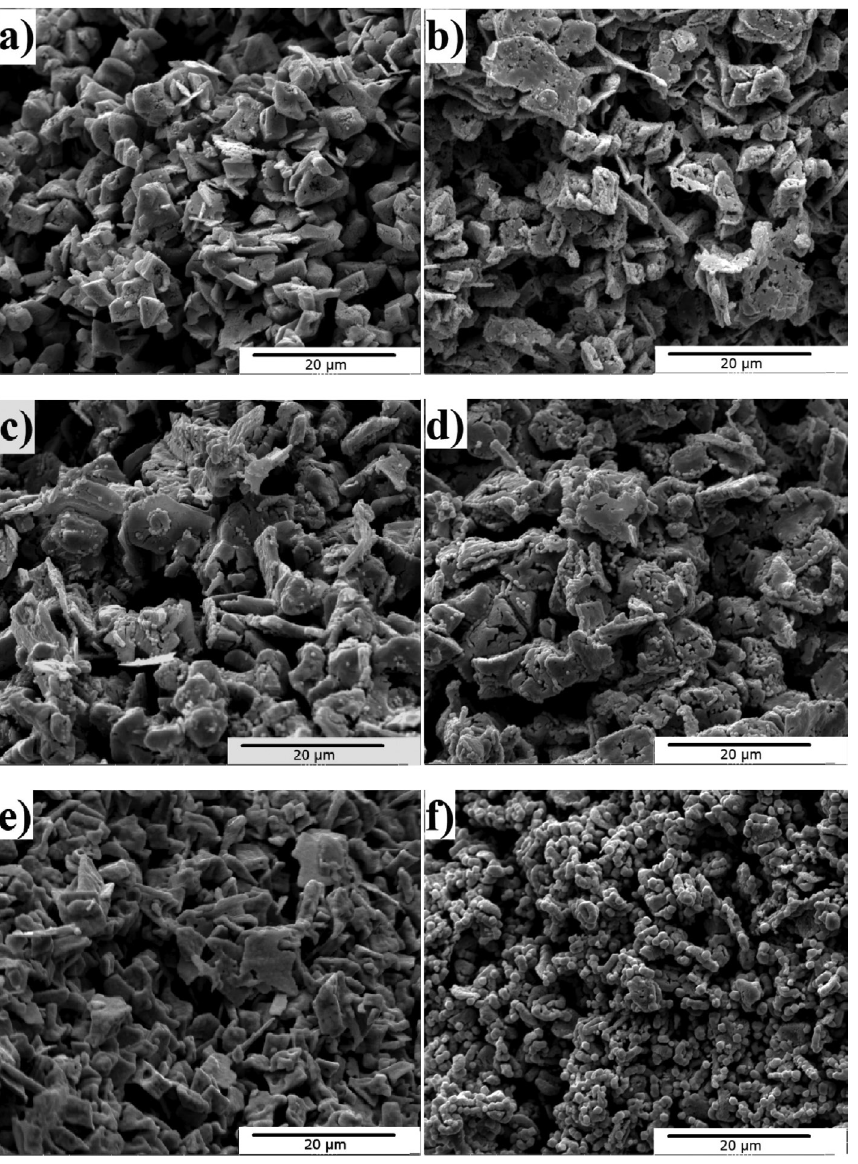
Fig. 4: Morphologies of Mo by reducing MoO 2 powders in dry hydrogen at different temperatures: (a) 1123 K, (b) 1173 K, (c) 1223 K, (d) 1273 K, (e) 1323 K, (f) 1393 K (SEM